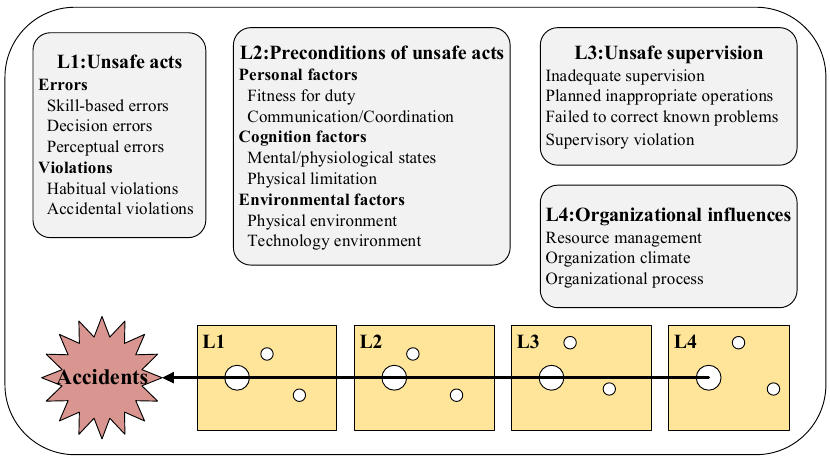
Figure 2. The HFACS framework. Figure 2. The HFACS